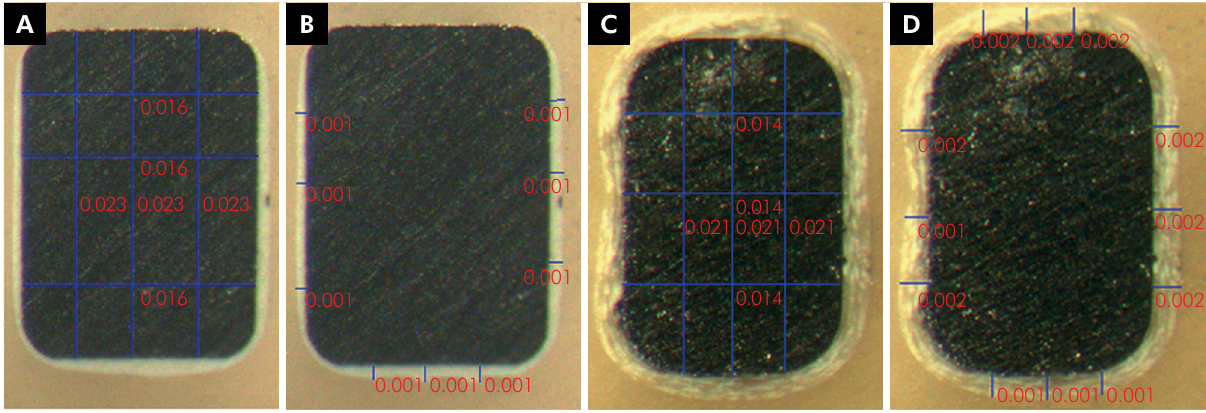
Figure 1. Stereomicroscope images of the transverse section illustrating the following measurements: A) Titanol Cosmetic inner dimensions; B) Titanol Cosmetic coating thickness; C) Biocosmetic inner dimensions; D) Biocosmetic coating thickness. Original magnification